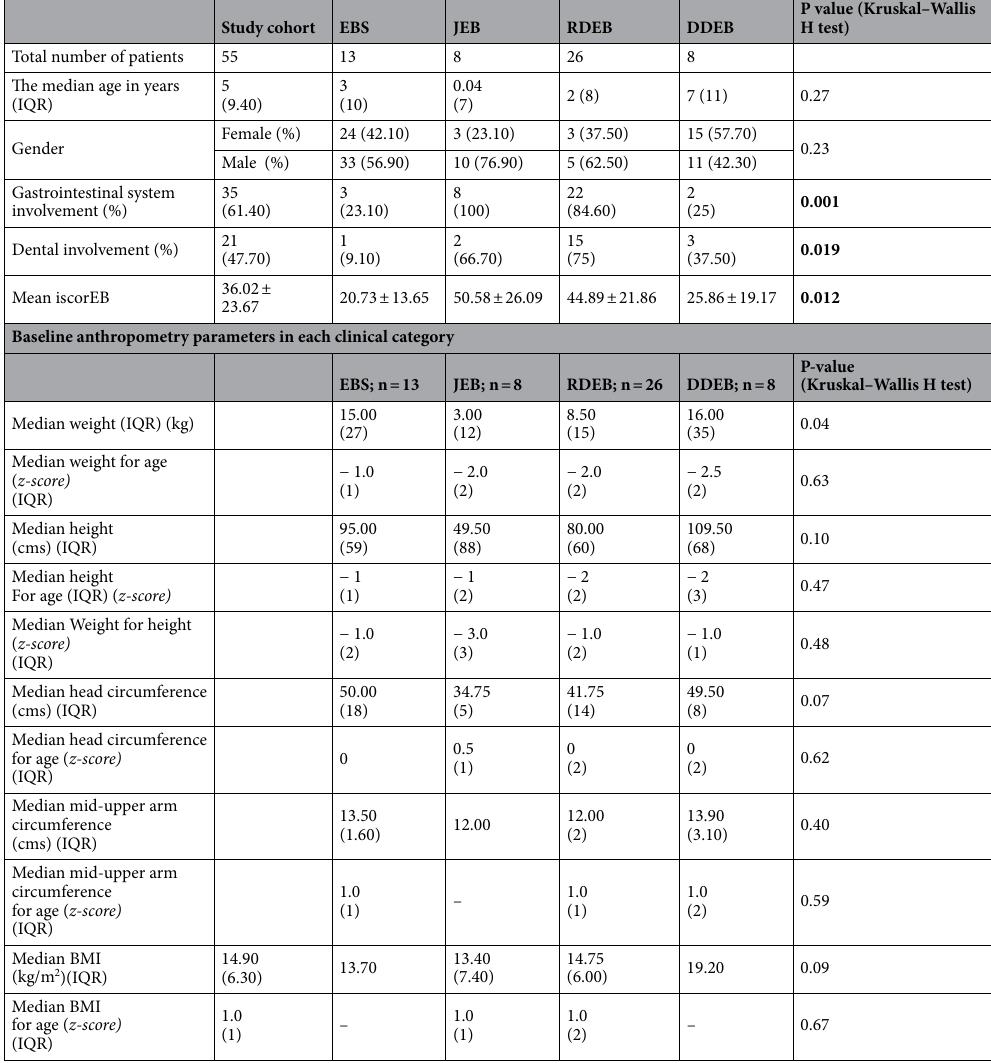
Table 2. Baseline clinical characteristics in study subgroups. EBS Epidermolysis bullosa simplex, JEB Junctional Epidermolysisbullosa, RDEB Recessive dystrophic Epidermolysisbullosa, DDEB